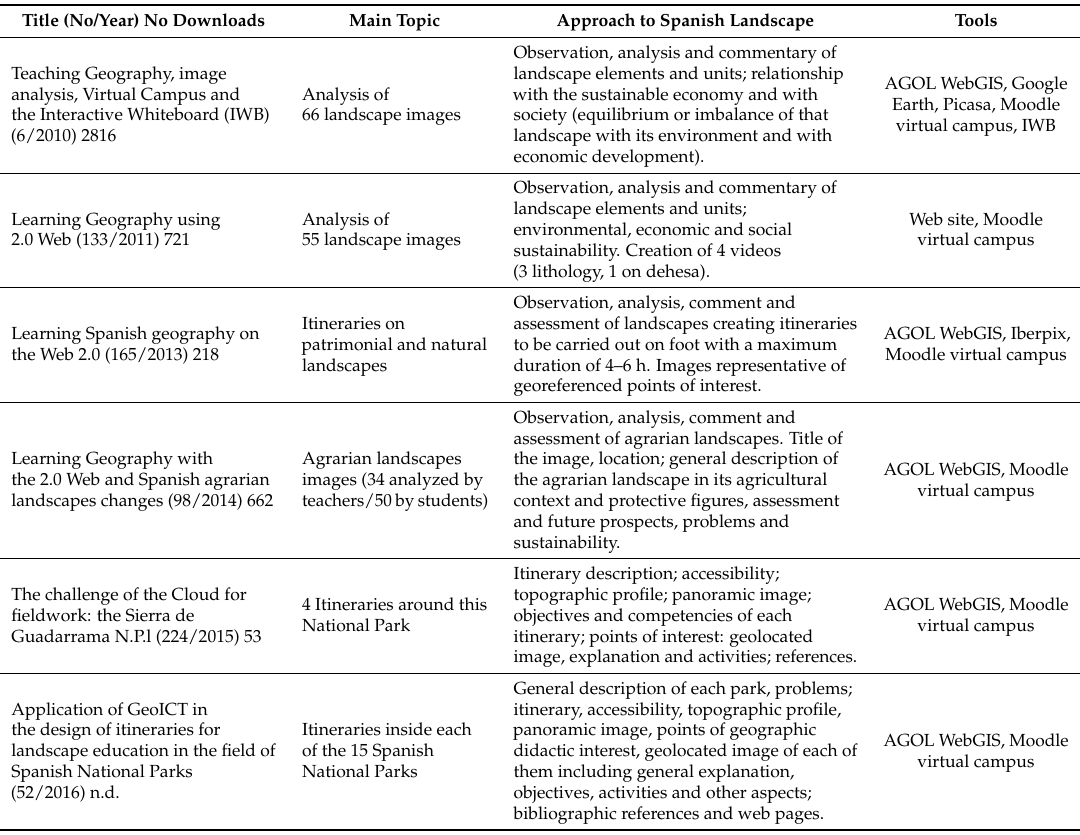
Table 1. Innovative teaching projects (PIMCD) (see also Appendix